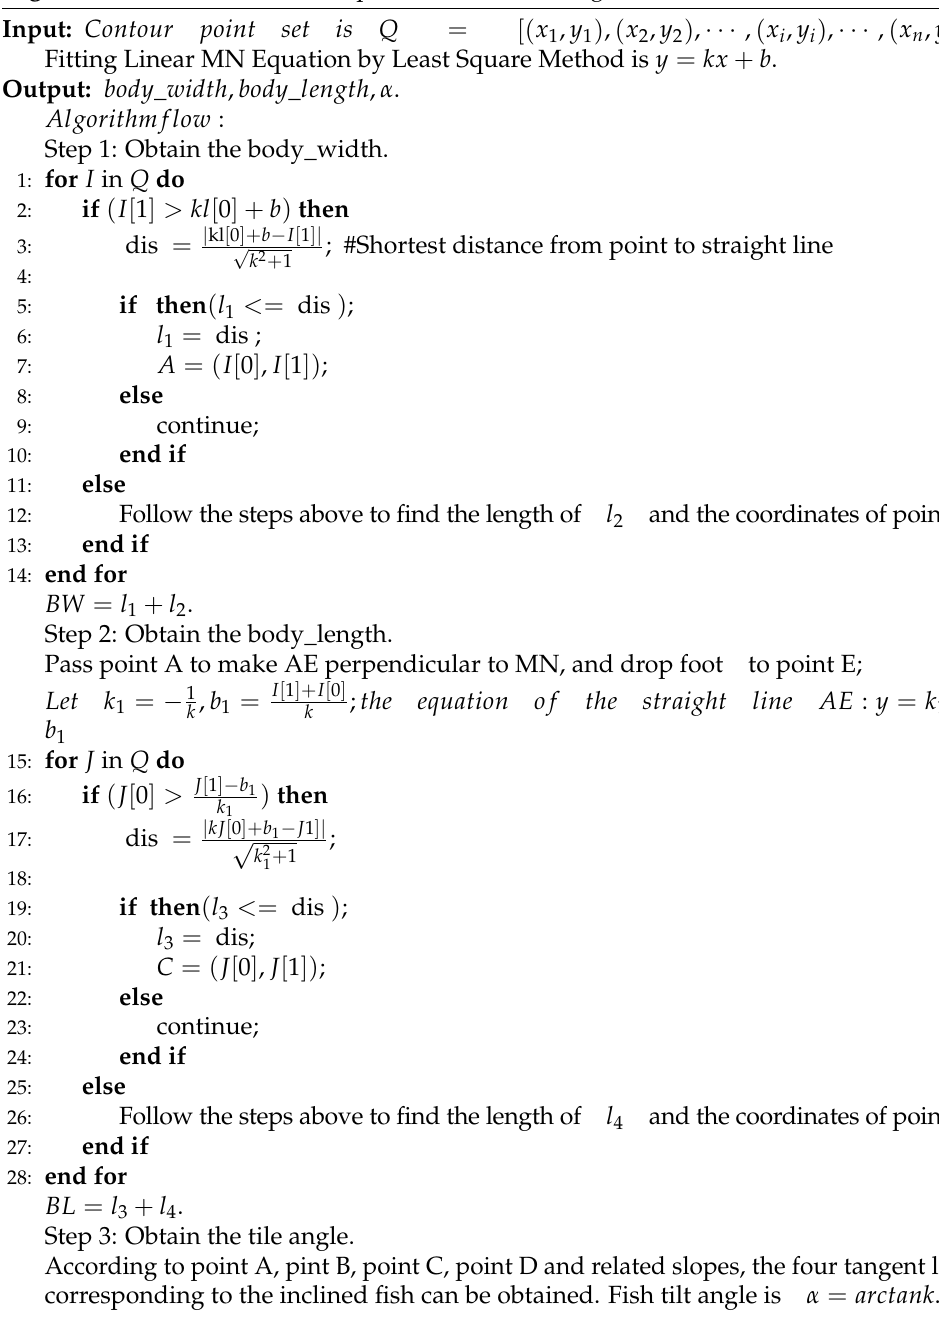
Algorithm 1 Pseudo code description of the line fitting